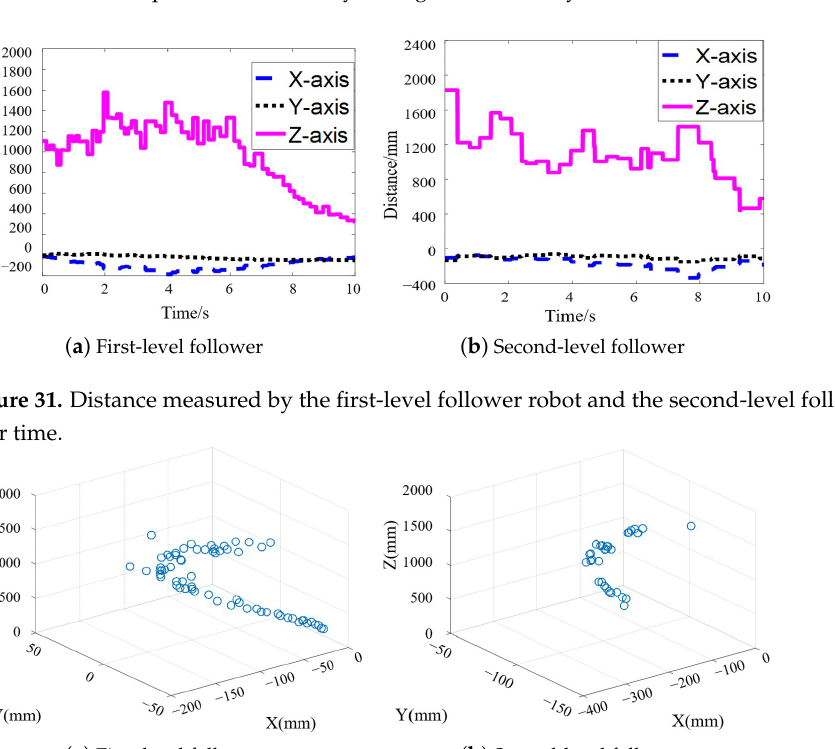
Figure 30. The yaw angle measured by the vision of first-level follower robot and the second-level follower robot compared with the self yaw angle measured by the MENS sensor over time.